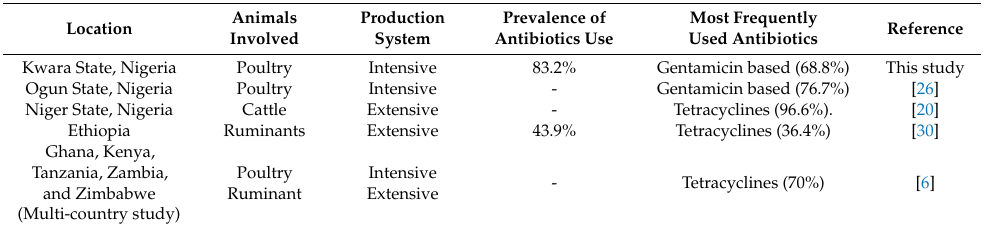
Table 7. Comparison of antibiotics usage across Nigeria and